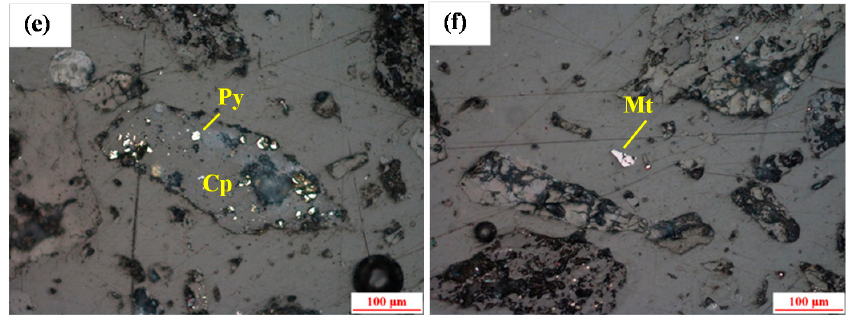
Figure 1. Optical microscopy images of raw ore observed with: ( a ) and ( b ) non-cross-polarized light; ( c ) and ( d ) cross-polarized light; ( e ) and ( f ) reflected light. (Cp: collophanite; Cm: clay minerals; Ap: apatite; Qf: Quartz and feldspar minerals aggregate; Dol: dolomite; Py: pyrite; Mt: magnetite.)